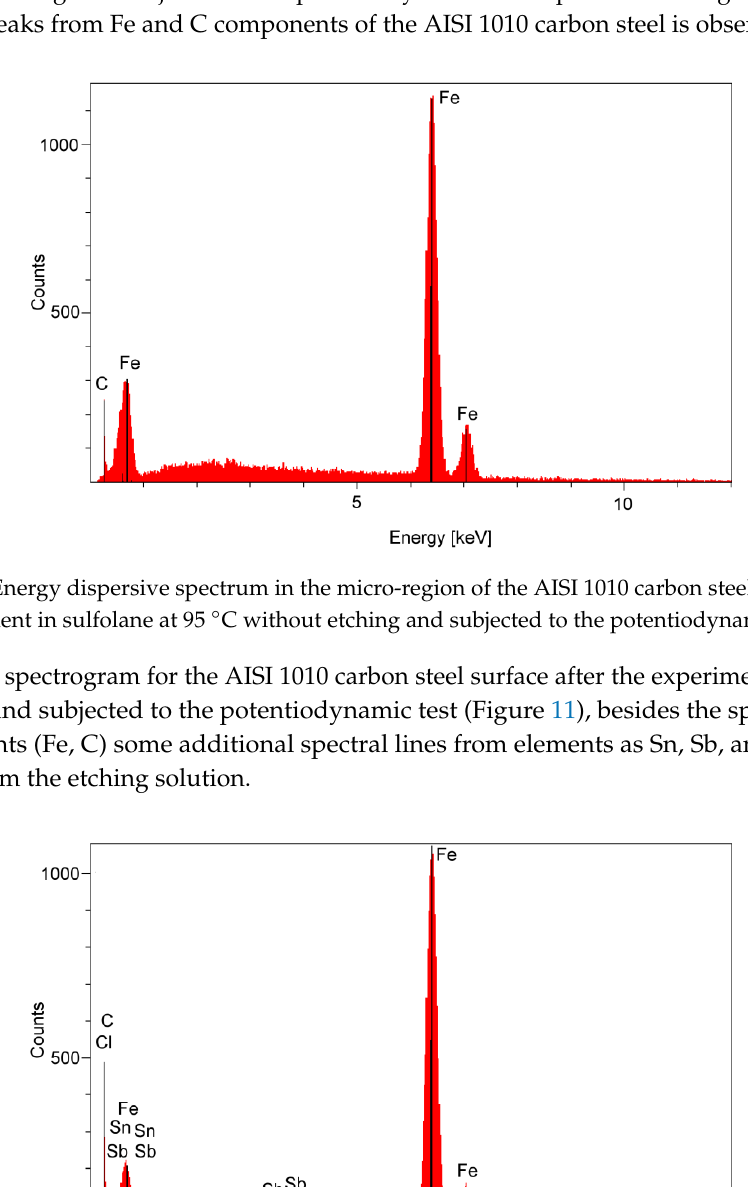
Figure 9. SEM image of the AISI 1010 carbon steel surface after the experiment in sulfolane at 95  C and etchig, and then the potentiodynamic test: on-top general view of the material with a selected micro-region, and with the corresponding EDS map of Fe, C, Sn, Sb, and Cl element distribution.